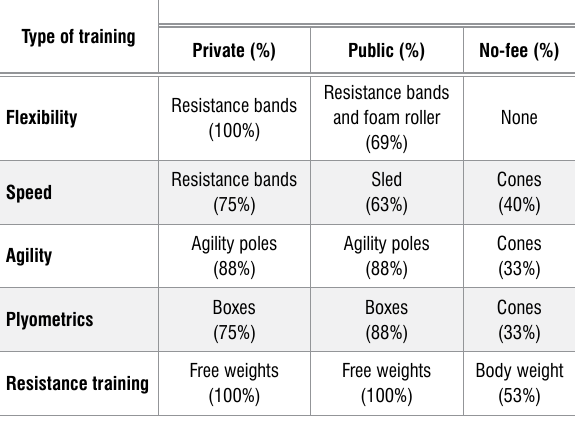
Figure 1: Different physical parameters tested (%) across the schools ( n According to the coaches’ responses, the most commonly tested measure was speed (58%), which remained the most popular for private schools (75%) and no-fee schools (27%) alike (Figure 1). The public schools indicated a preference for testing muscular strength (88%), with the only other parameter tested by no-fee schools being aerobic capacity (Figure 1). Overall, the most common tests were for speed (40-m and 100-m sprint tests), aerobic capacity (multi-stage fitness test), anaerobic capacity (repeat sprint ability test), muscular strength (one-to-five repetition maximum test), muscle endurance (maximum push-up, pull-up and sit-up tests), agility (Illinois agility test), muscle power (standing broad and vertical jump tests) and flexibility (sit and reach test). Flexibility, speed, agility, plyometrics and resistance training were the most common practices. The most common types of equipment used for these training exercises are shown in Table 2. Most common (%) equipment used for each type of training